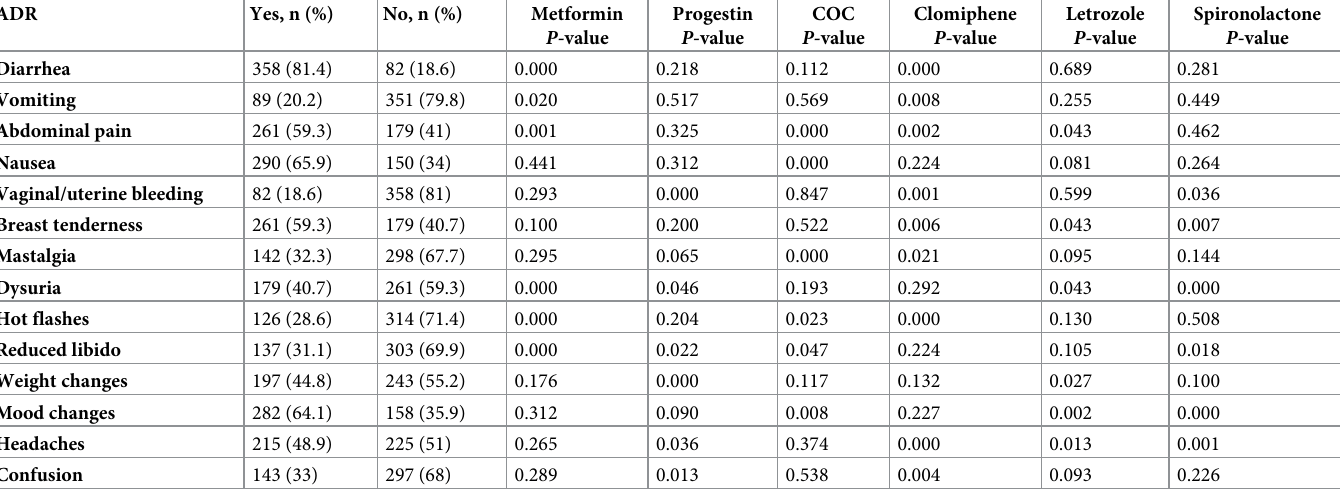
Table 5. Association between adverse drug reactions and prescribed drug use.